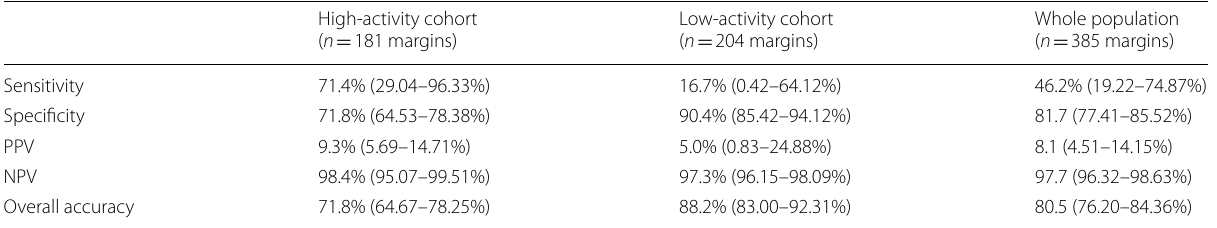
Table 3 Diagnostic accuracy of FAR for intraoperative margin assessment of intact WLE specimens compared to histopathology for a high decay corrected [ 18 F]FDG activity versus a low decay corrected [ 18 F]FDG activity at time of FAR imaging as well as for the